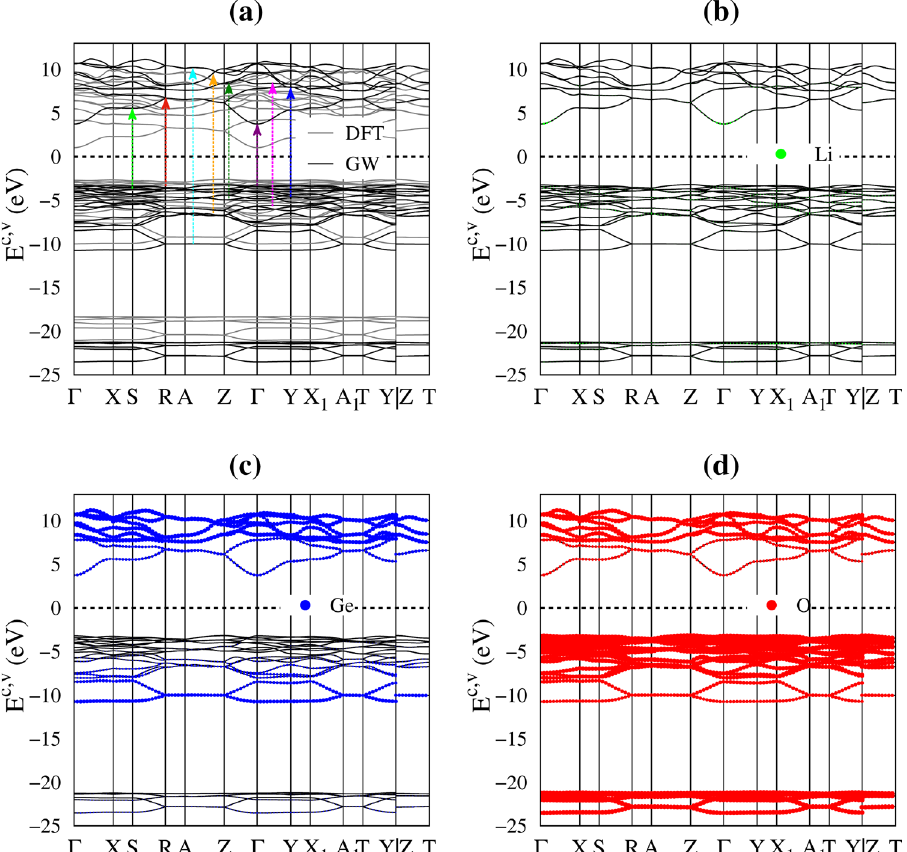
Figure 2. ( a ) The quasi-particle band structure along the high-symmetry points in the wave-vector space (solid-black lines), the standard DFT calculation (the solid-grey lines) is also added for comparisons, the vertical-colored arrows indicate the optical excitations. The domination of ( b ) Li, ( c ) Ge and ( d ) O atoms (the green, blue and red circles) in the electronic band structure. The Fermi level is denoted by the dash-black